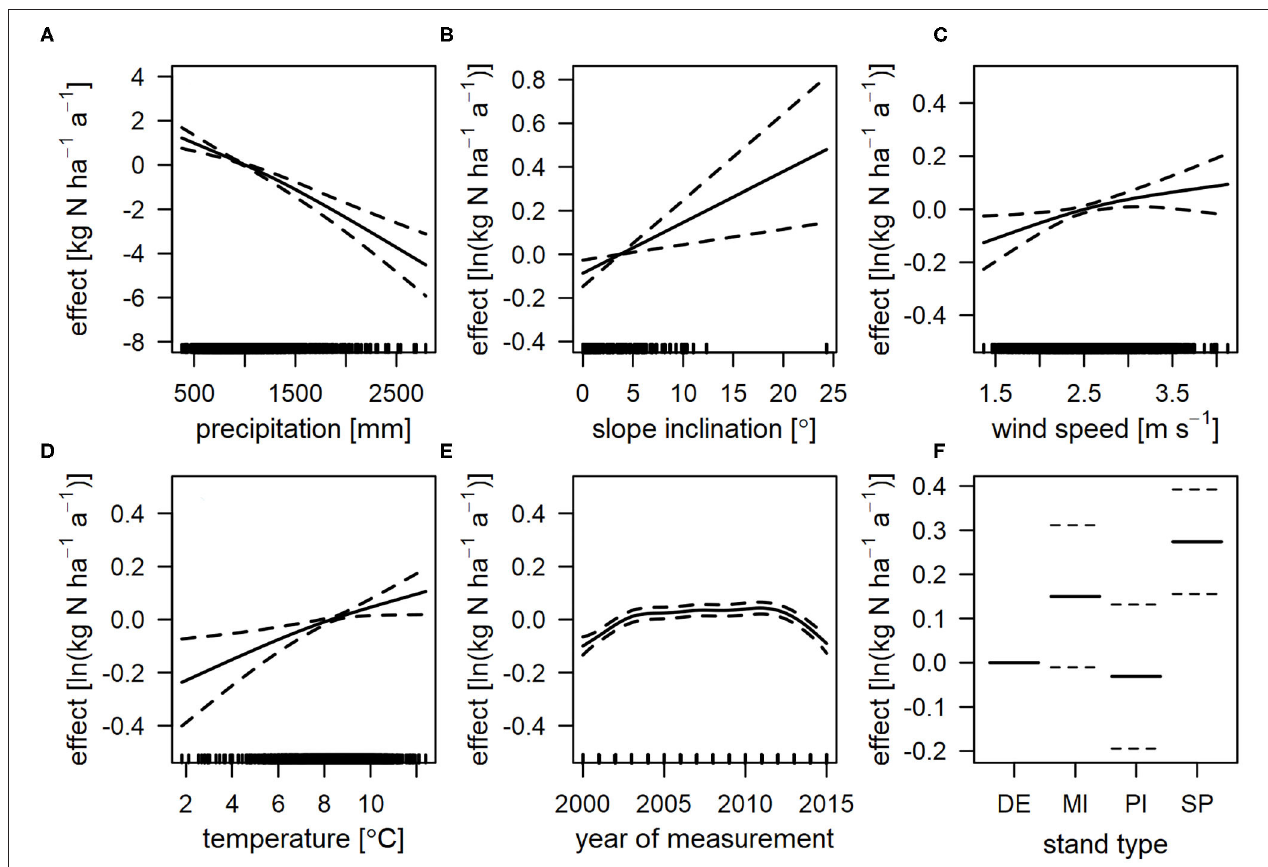
FIGURE 5 | Partial effect of precipitation (A) , slope inclination (B) , wind speed at 2m height (C) , temperature (D) , year of measurement (E), and stand type (F) on 1 TIN between the canopy budget (CBM) and emission based method (EBM) for wet deposition (A) and dry deposition (B–F) . Positive effects indicate a tendency for higher TIN deposition estimates of the CBM compared to the EBM. Note the log-transformed data for dry deposition. Dashed lines indicate 95% pointwise prognosis intervals. The covariate is displayed as marks along the x-axis. (DE, deciduous forest; MI, mixed forest; PI, pine forest; SP, spruce